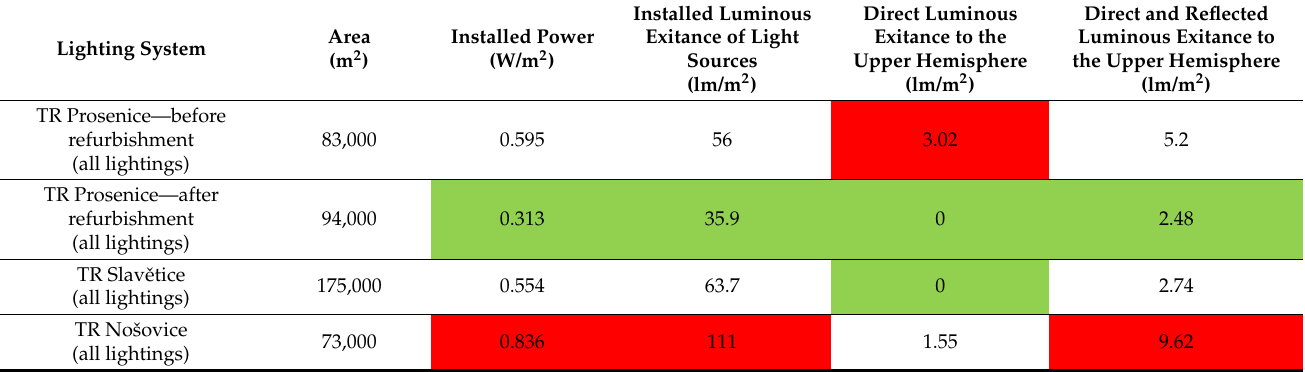
Table 13. Final comparison of the area-related specific upward light emissions from lighting